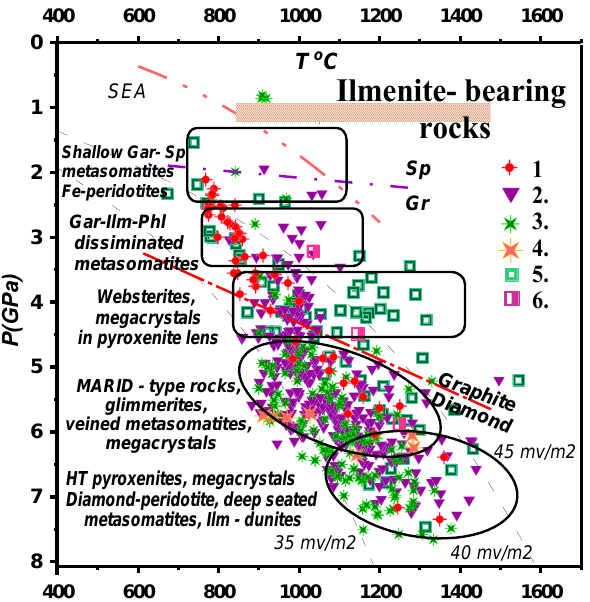
Figure 8. PT diagram for kimberlitic ilmenites and silicate miner- als from ilmenite-bearing xenoliths and xenocrysts intergrowths. 1. Garnet thermobarometry for peridotites and pyroxenites (Ashchep- kov, 2010a); 2. Ilmenite thermobarometry (Ashchepkov et al., 2000) for the xenoliths with ilmenites associations; 3. Clinopyroxene thermobarometry: according to T ◦ C (Nimis and Taylor, 2000) – P (GPa) (Ashchepkov, 2003); 4. Clinopyroxene thermobarome- try (Nimis and Taylor, 2000); 5. Orthopyroxenes thermobarometry (Brey and Kohler, 1990) – (McGregor, 1974); and 6. Ilmenite ther- mobarometry (Ashchepkov et al.,